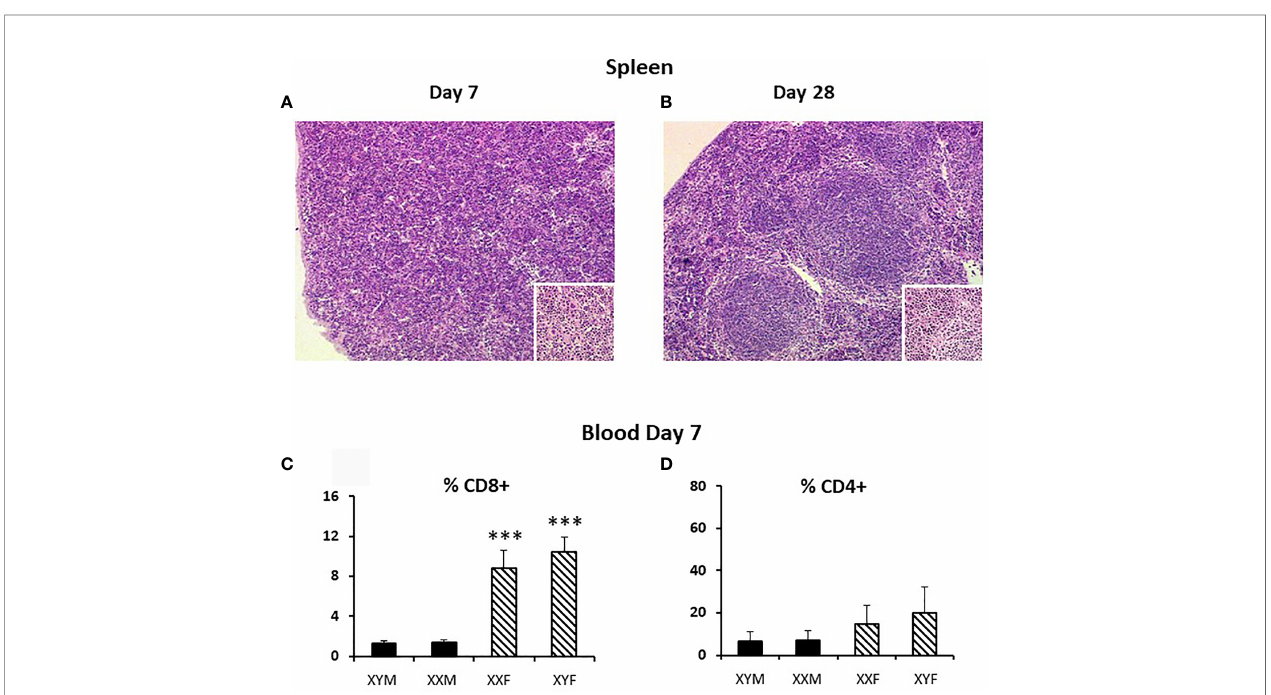
FIGURE 4 | Pup spleen histology at 7 and 28 days and T cell content of the blood at 7 days. Spleens were fi xed and embedded in JB4 (a water soluble, glycol methacrylate-based embedding medium) before sectioning (@ 2.5 m m) and staining with hematoxylin and eosin. Magni fi cation, 40X and 100X for insets. Blood was collected into heparinized tubes and the red blood cells lysed prior to staining for fl ow cytometry. Data in c and d are presented as a percentage of gated lymphocytes. The means ± SD are derived from 13 XYM, 14 XXM, 22 XXF, and 13 XYF animals at day 7. ***, different from both male genotypes, p<0.001.